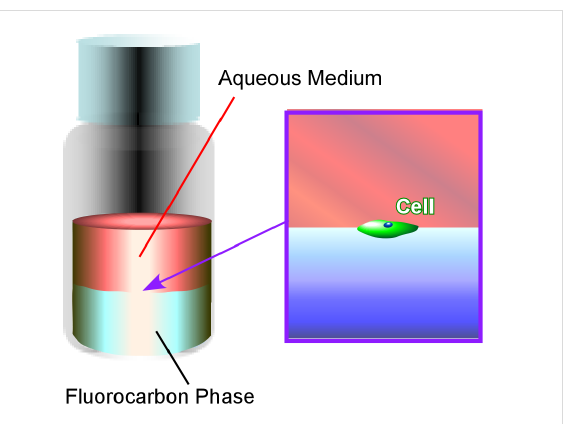
Figure 25: Cultures, organizations, and differentiation controls of living cells a liquid-liquid interface between aqueous media and fluoro- carbon